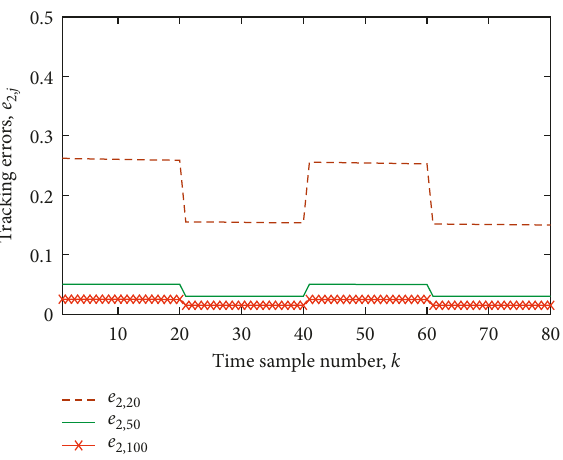
Figure 13: Tracking errors profiles of ILC e